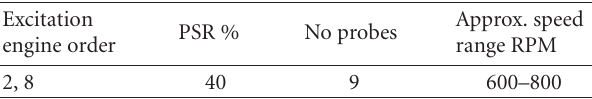
Table 4: Double resonance experimental test